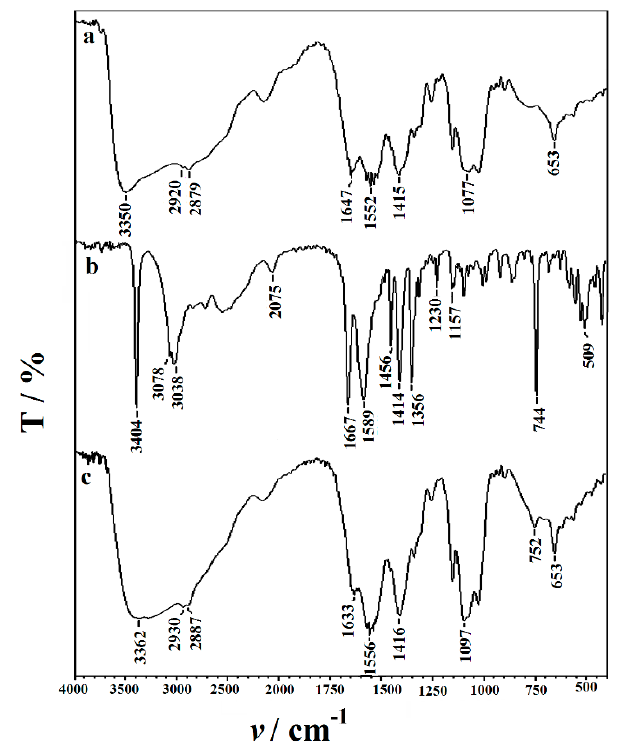
Figure 2. The Fourier Transform Infrared (FT–IR) spectra of ( a ) chitosan, ( b ) Trp and ( c ) the Trp-chitosan composite.